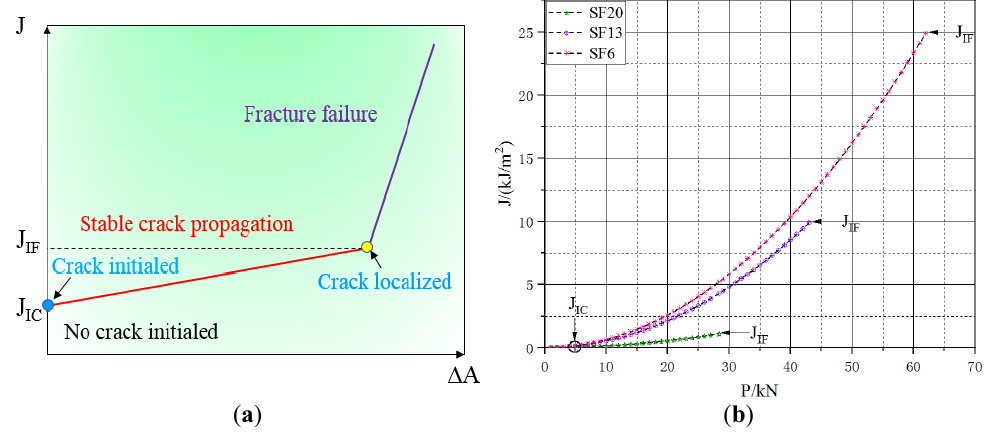
Figure 12. Evolution of the J-integral with ( a ) variation in crack area (Schematic diagram) and ( b ) applied load (J-integral curve).